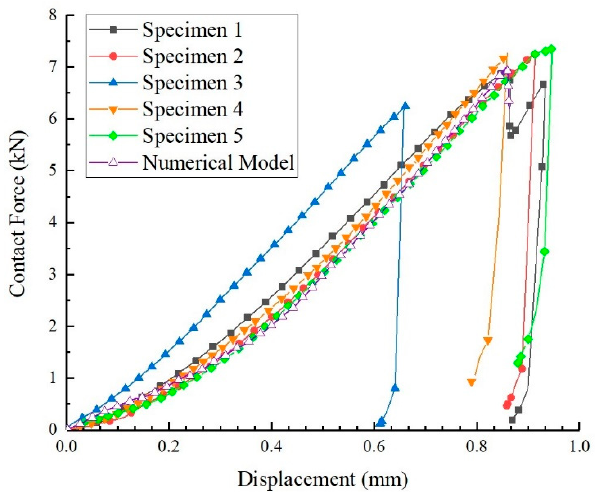
Figure 13. Force–displacement curve in numerical